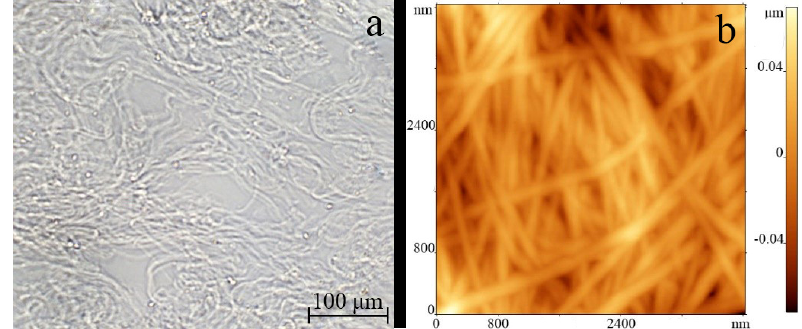
Figure 3. Micrograph of the BC aqueous dispersion ( a ) and AFM image of the film of BC ( b ).